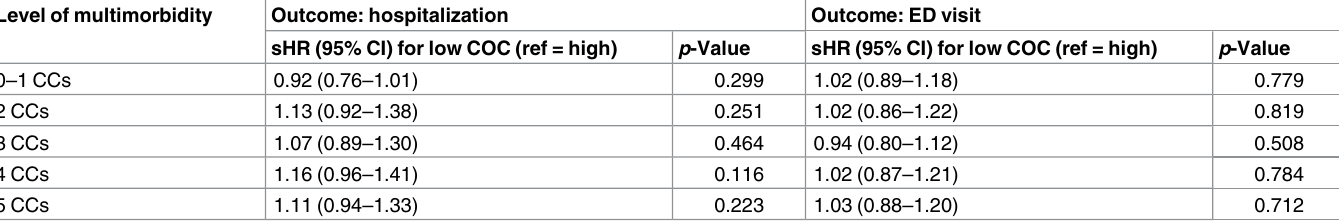
Models adjust for all covariates: age, sex, income, marital status, rurality, prior hospitalizations, prior emergency department use, Minimum Data Set Health Status Index, Changes in Health, End-stage disease and Symptoms and Signs scale, plus interaction between COC and level of multimorbitiy used to derive